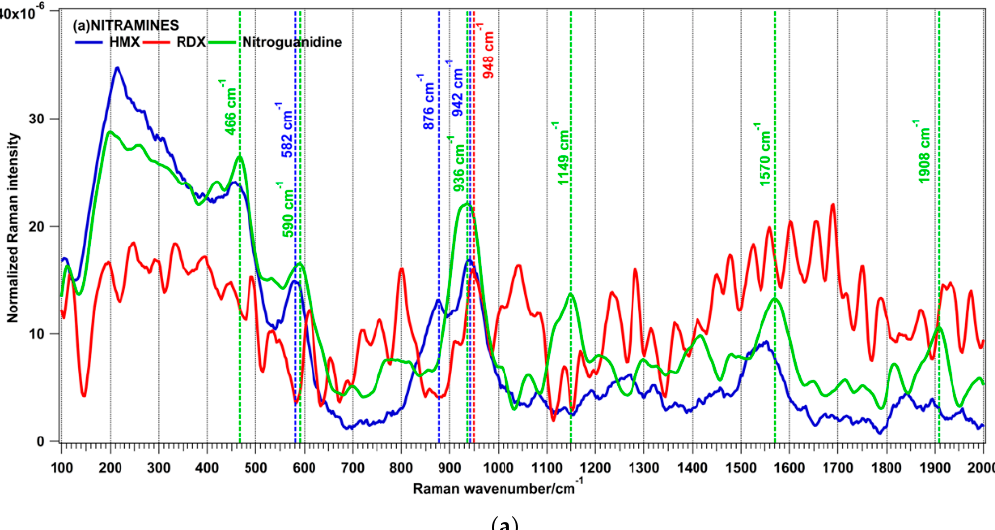
Figure 6 . Cont. Figure 6. Cont